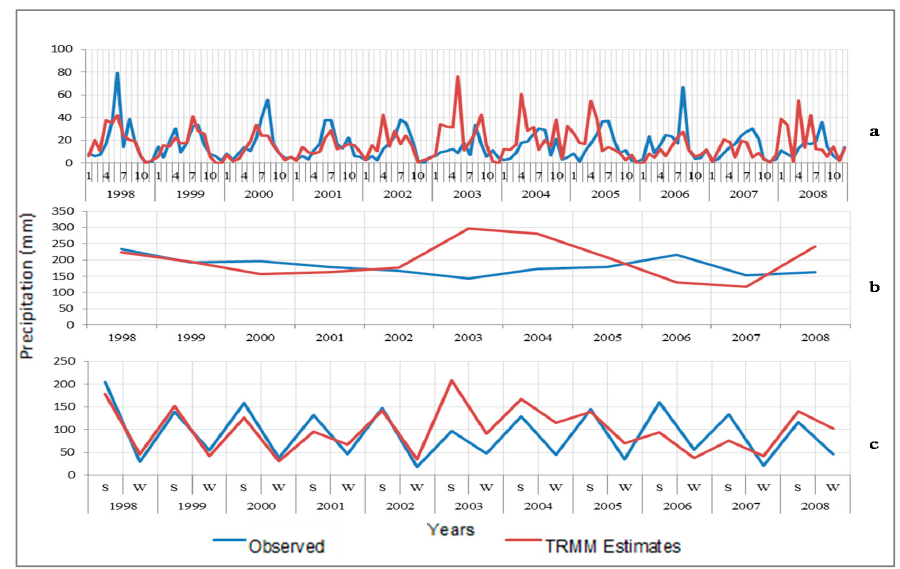
Figure 3. Time series of TRMM estimates and observed gauge data for mean rainfall totals at Khunjrab station; ( a ) monthly, ( b ) annual, and ( c ) seasonal (S = summer, W = winter).